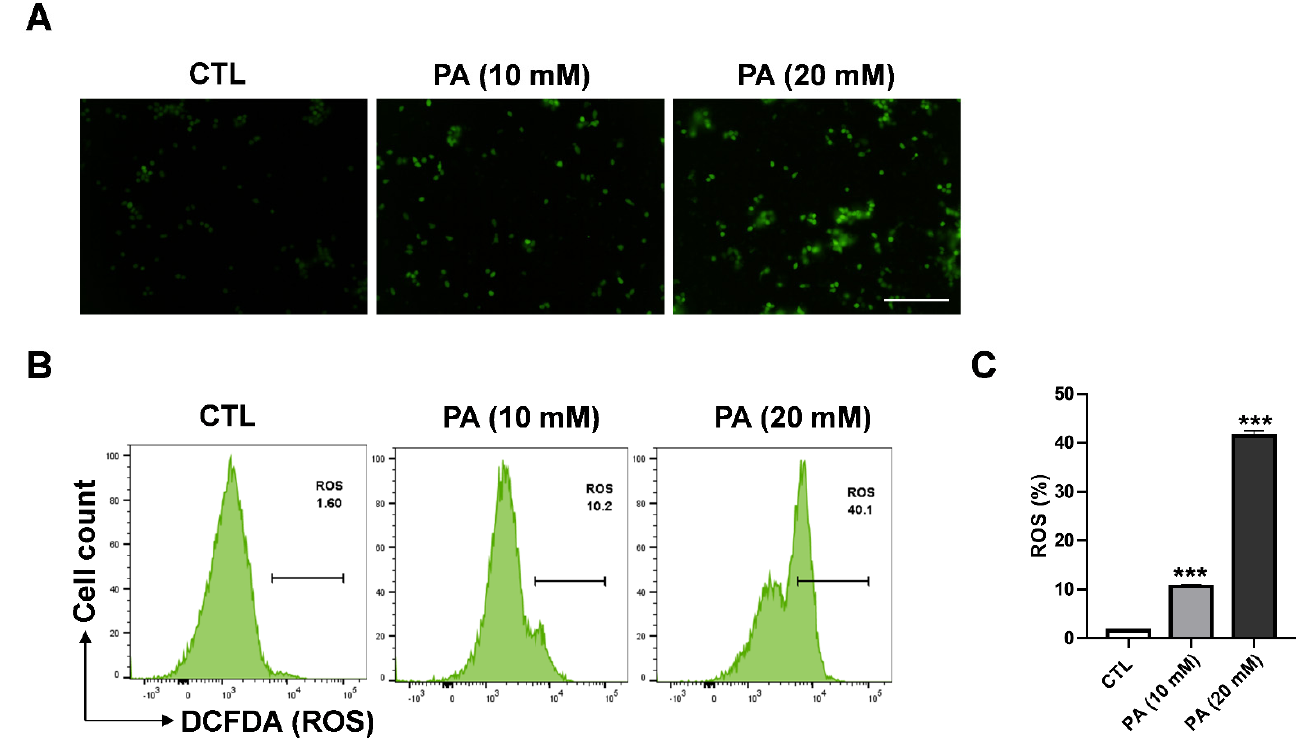
Figure 3. PA-induced intracellular ROS generation in HeLa cells. ( A ) PA-induced ROS as observed via fluorescence microscopy (scale bar: 200 µ m). ( B ) Effects of 10 mM and 20 mM of PA for 48 h on ROS levels as measured using DCF-DA and a flow cytometer. ( C ) Quantification of ROS levels. Values indicate means ± SEM. ( n = 3, *** p ≤ 0.001).